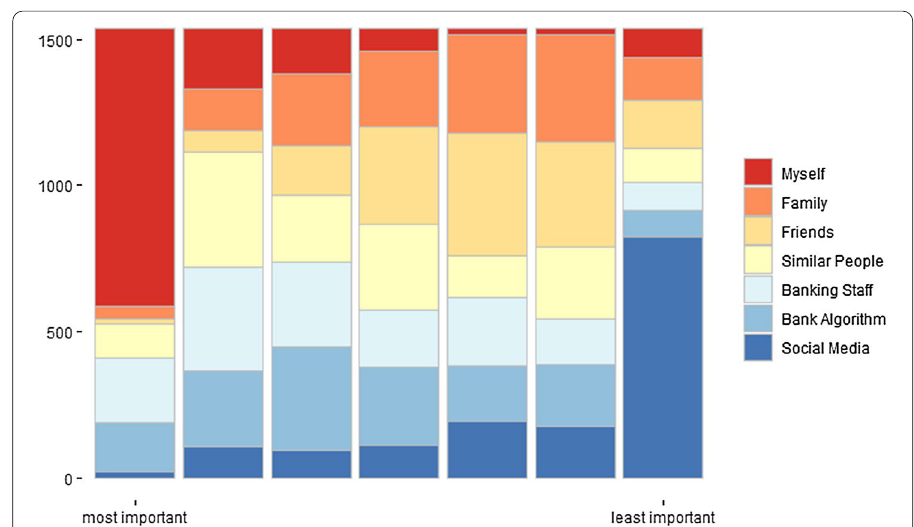
Fig. 5 Influencing factors and information sources of investment decisions